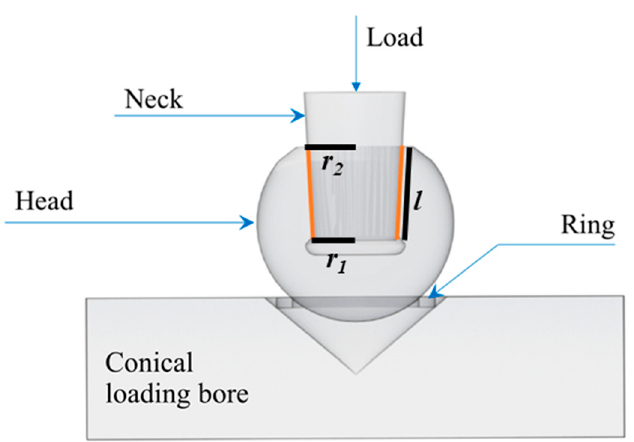
Figure 1. Schematic representation of the burst-strength testing equipment, following the international standard ISO 7206-10.